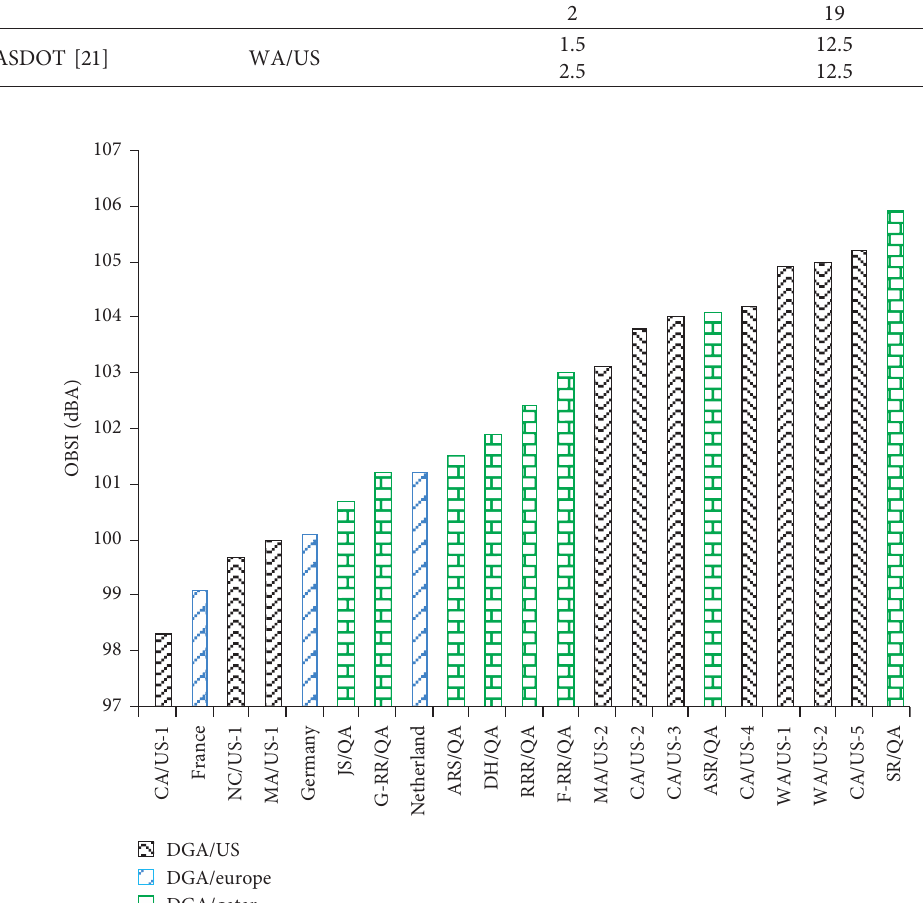
Figure 6: Comparison of measured noise intensity levels for DGA pavements in Qatar, Europe, and the